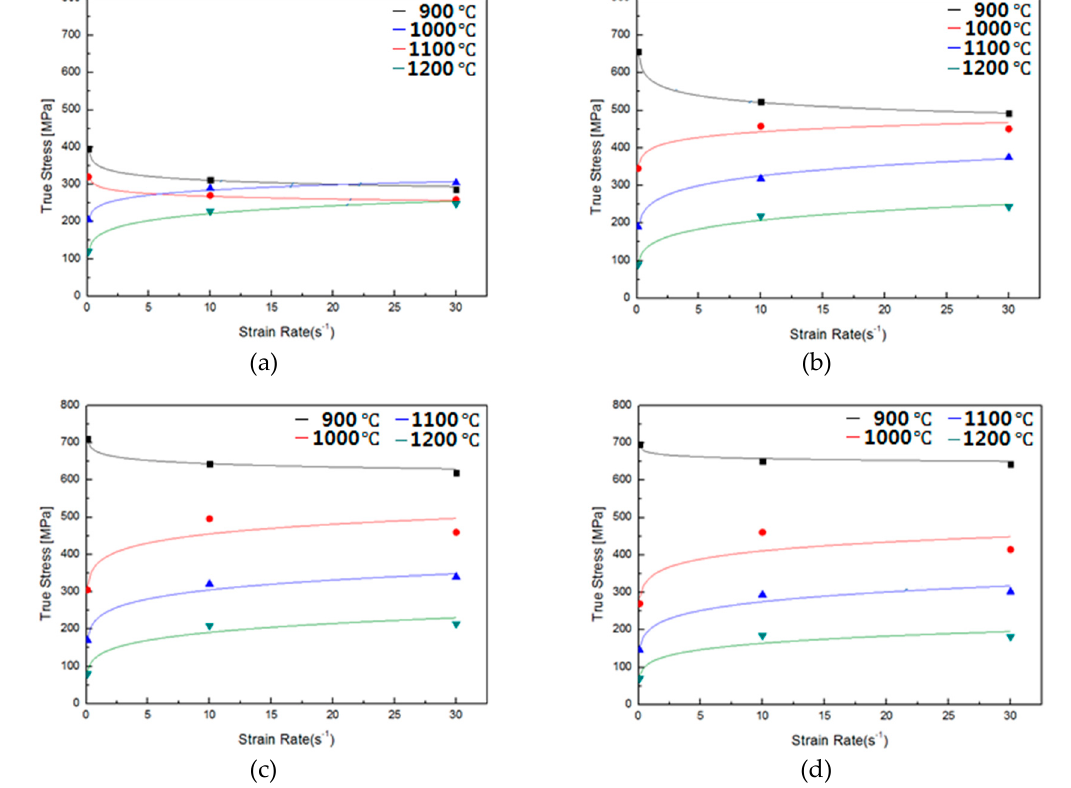
Figure 2. Graph of true stress versus strain rate at different temperatures and true strains: ( a ) true strain 0.1, ( b ) true strain 0.3, ( c ) true strain 0.5, ( d ) true strain 0.7. Table 1. Values of the strength coefficient ( C ) and strain rate sensitivity ( m ) at different temperatures and true strains.